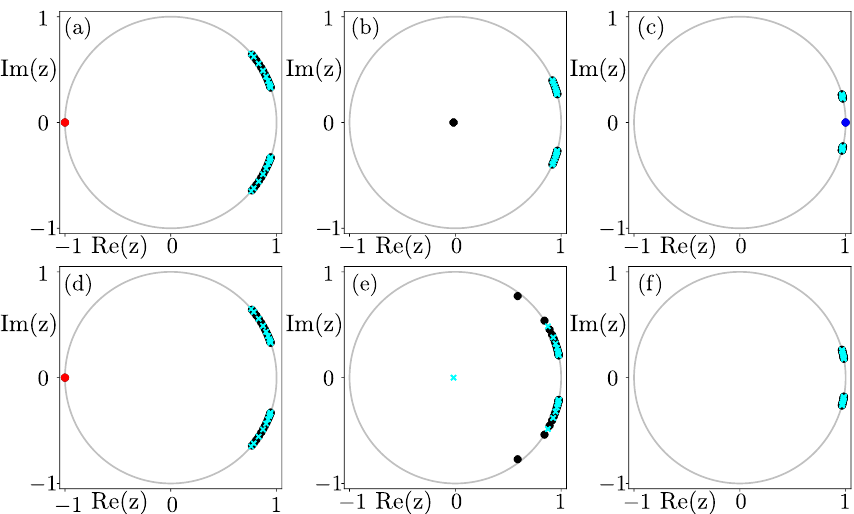
Figure 6: The dependence of det [ ˜ r ] at eigenphases φ = 0, π on the ratio γ = λ = 1. In panels (a) and (b) we use γ with λ x y and r is obtained by attaching leads only to the sites closest to the boundary of the 2D HOTI. In panel (c) however, r is calculated for leads attached to the full unit cell of the 2D system, while the parameters are the same as in panel (a). In all panels, the 2D system consists of 100 × 100 sites and it is connected to leads with hopping = 1 via a weak link with hopping strength t strength t lead